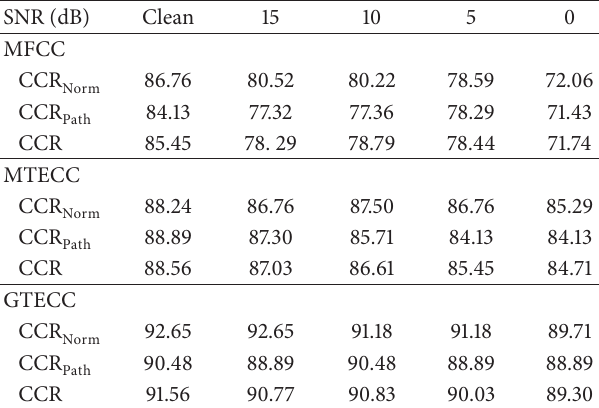
Table 1: Feature performance in clean and noisy